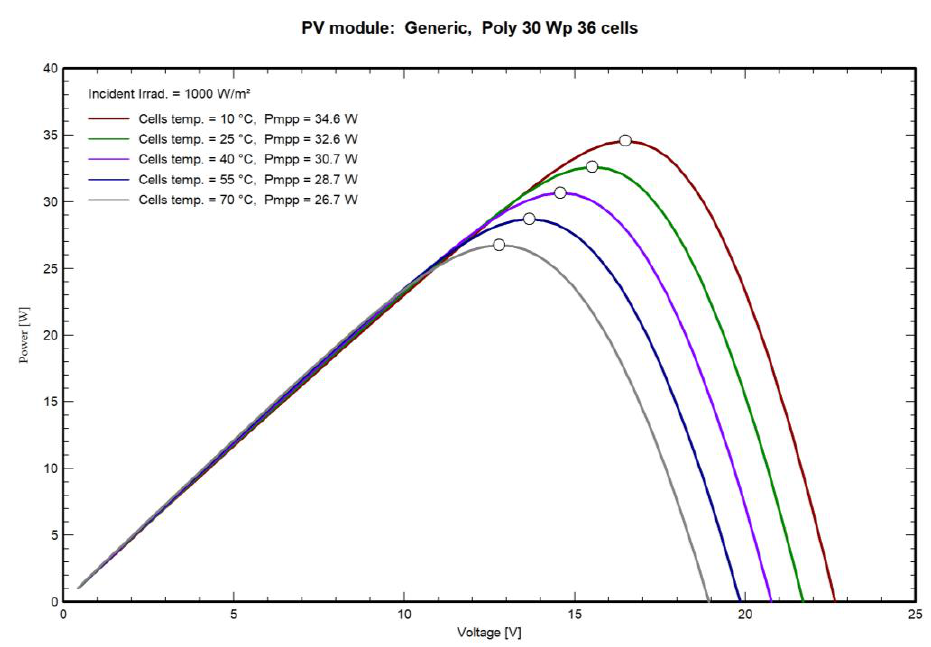
Figure 2. Effect of temperature on the P-V characteristics of the PV.